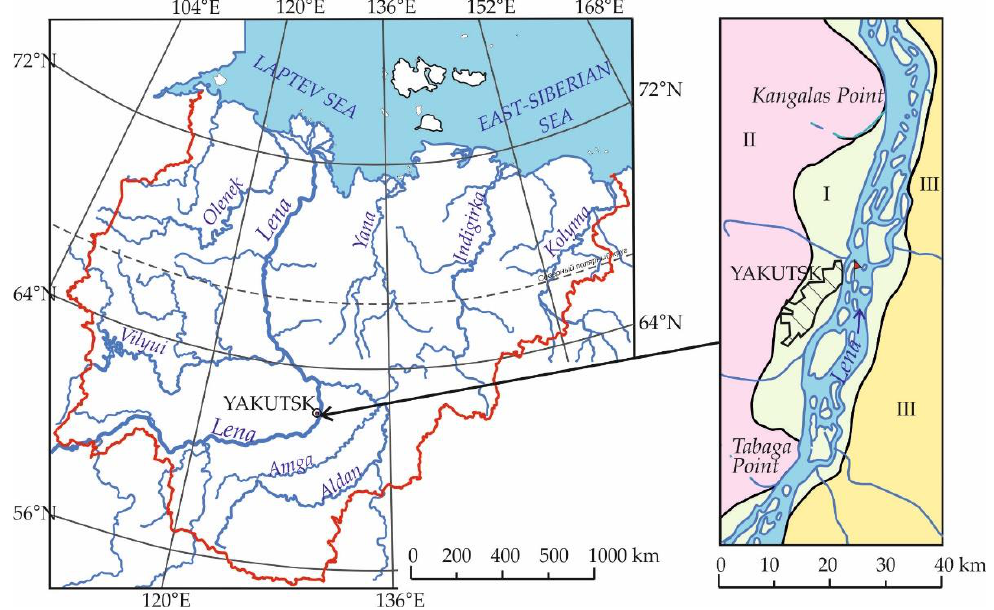
Figure 1. Study area on the Yakutia map and on the morphological scheme: I—Valley of the Lena River; II—Prilenskoe Plateau; III—the Lena-Amga plain; flag—hydrological gauge near Yakutsk.